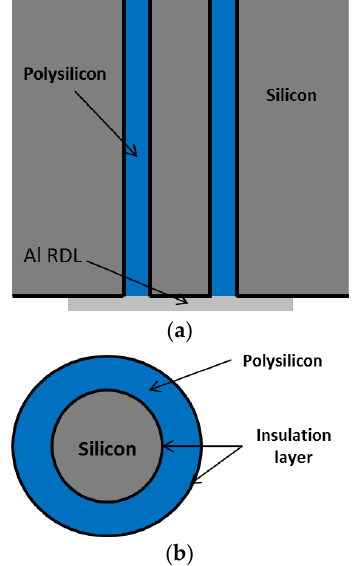
Figure 9. Structure of polycrystalline-silicon-based TSV Type B ( a ) in a cross-section view; ( b ) in a top view.